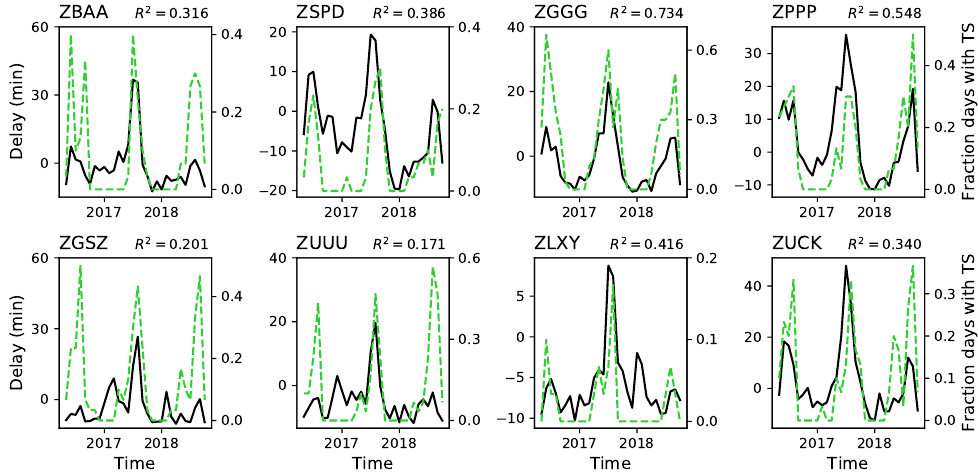
Figure 4. Evolution of the average monthly delay (black solid line) and of the fraction of days with thunderstorms (green dashed line, right Y axis), for the top eight Chinese airports.